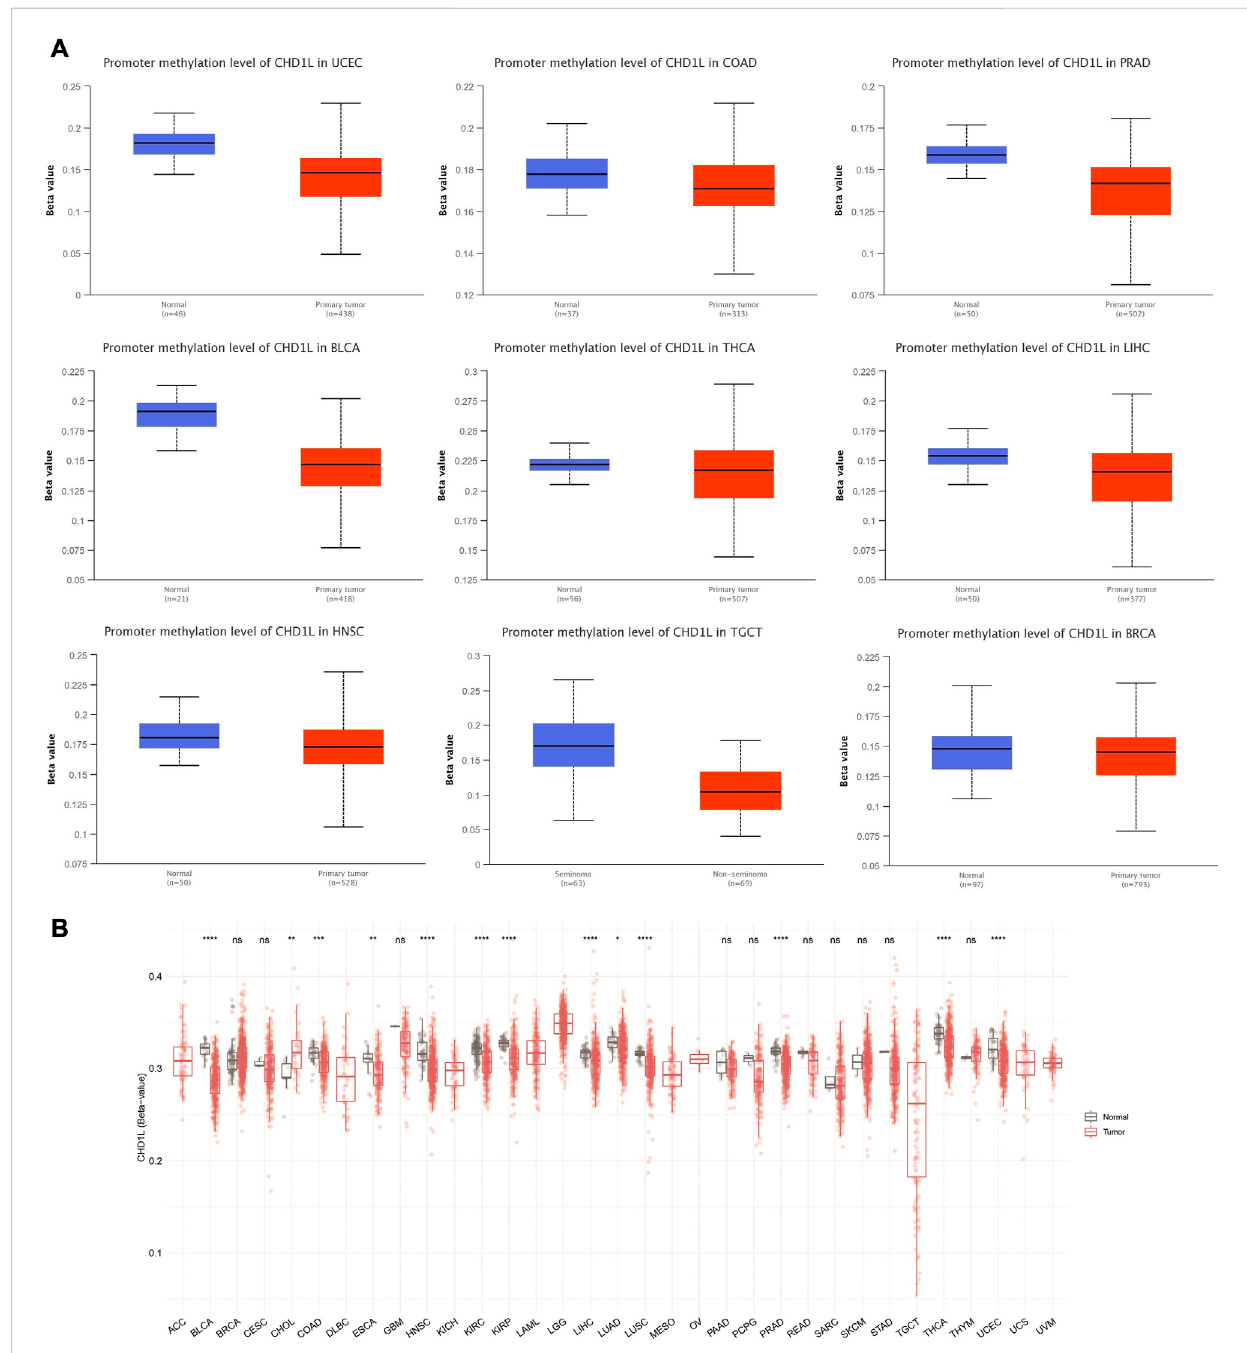
FIGURE 6 Differential methylation analysis of CHD1L in tumor samples versus normal ones. (A) Tumors experienced higher methylation in the CHD1L promoter region in normal samples versus tumors as assessed by UALCAN analysis. (B) Analysis of CpG-aggregated methylation of CHD1L in a list of human